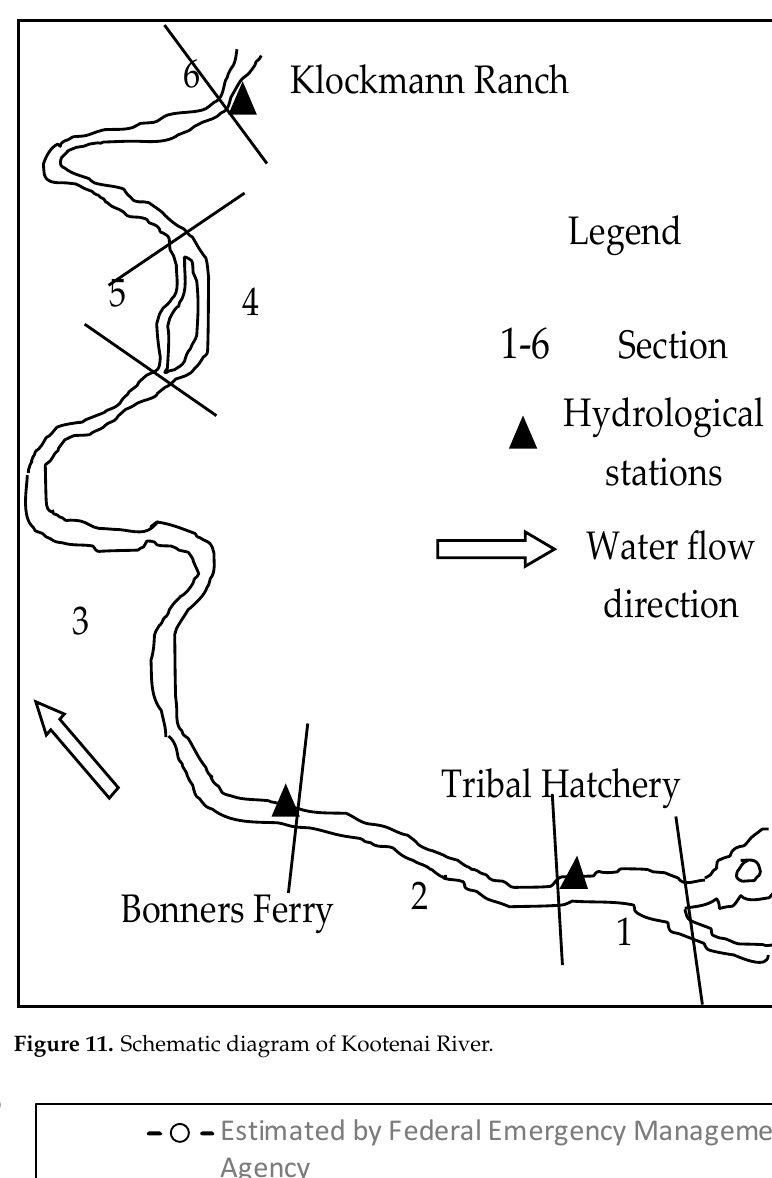
Figure 11. Schematic diagram of Kootenai River.